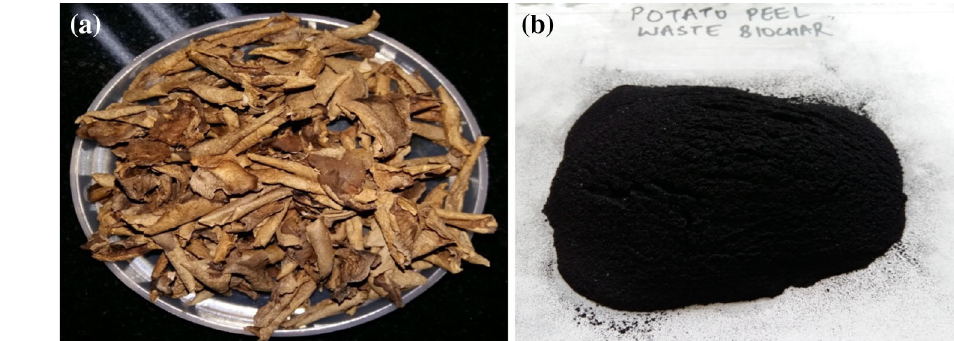
Fig. 1 Biochar preparation. a Potato peel waste, b grinded